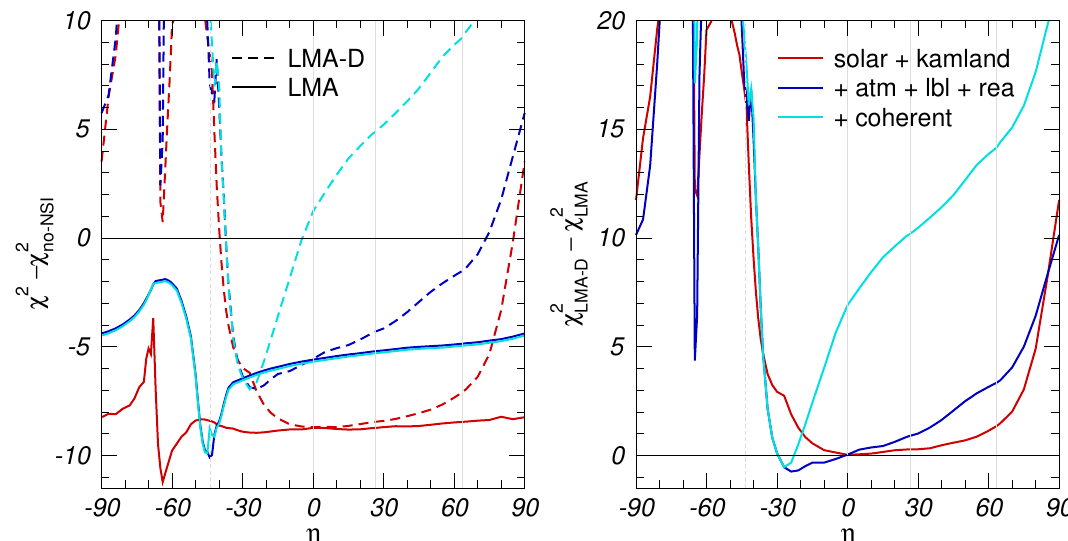
Figure 4.1: Left: ∆ χ 2 between the standard ( χ 2 ) and the NSI scenario ( χ 2 ( η ) ) no-NSI assuming the LMA solution (full lines) or the LAM-D solution (dash lines) for different data combinations as a function of the NSI quark coupling ( η ). Right: ∆ χ 2 between the LMA and LMA-D solutions as a function of η